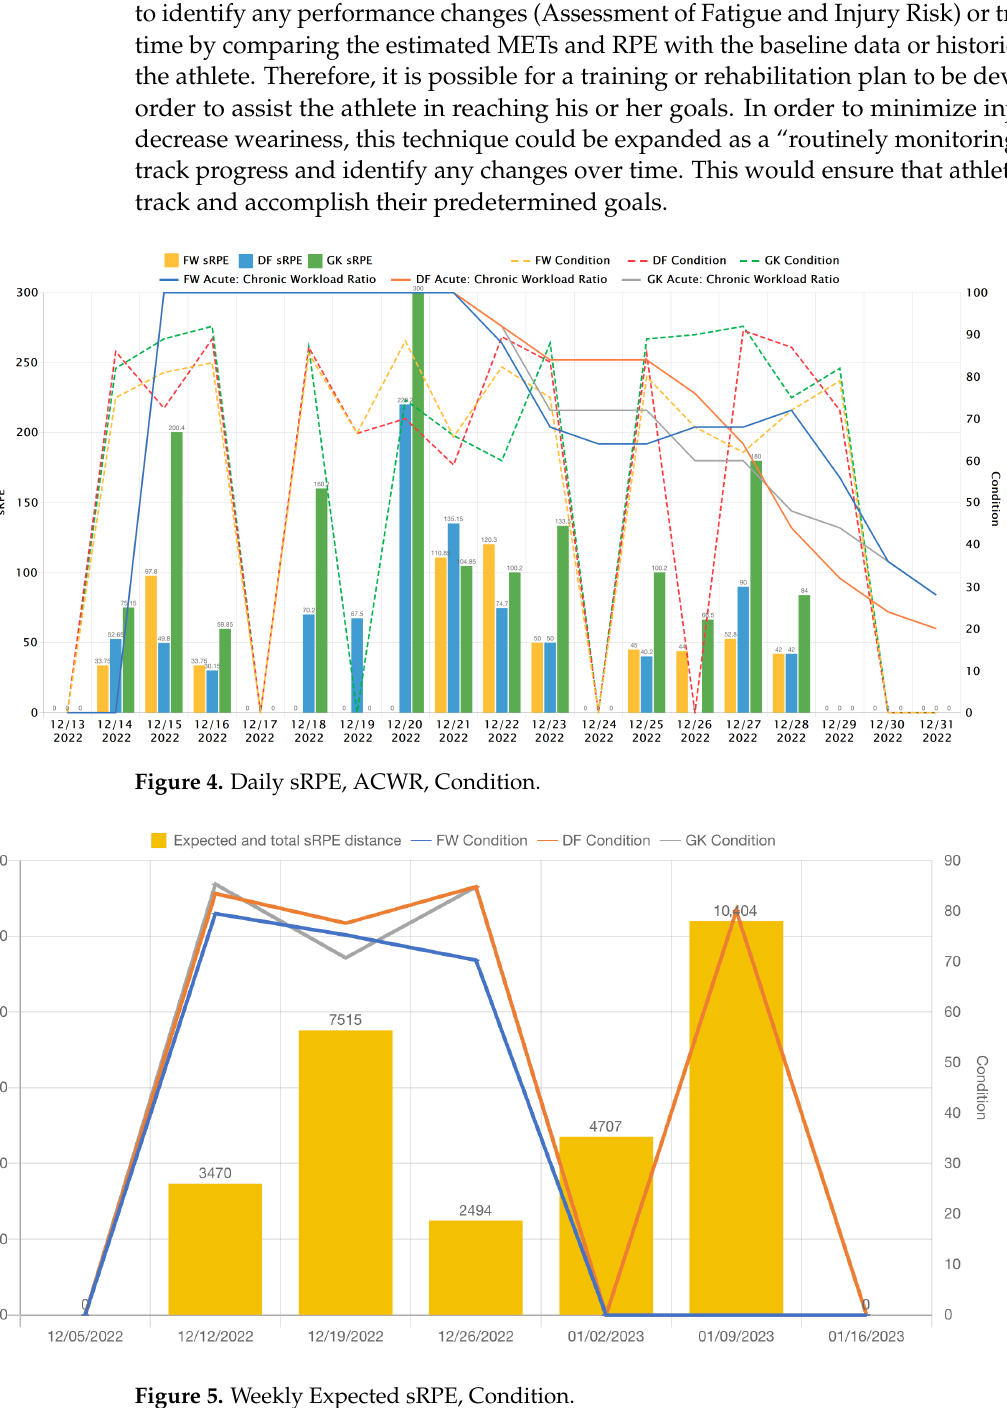
Figure 5. Weekly Expected sRPE,